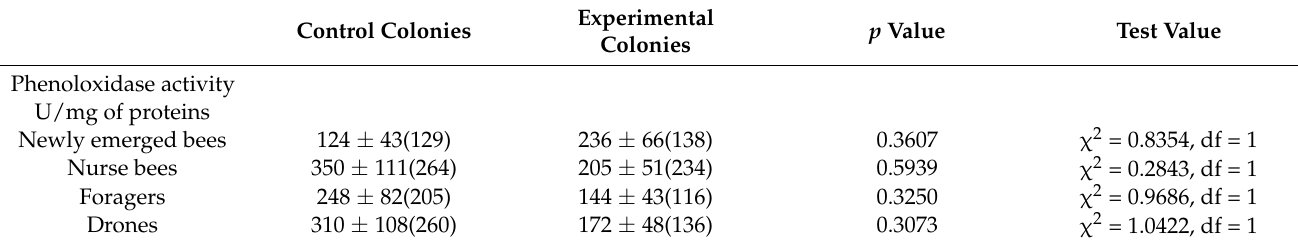
Table 1. Phenoloxidase activity in honey bees belonging to control and experimental colonies (queen caging + acid oxalic). Values are reported as mean ± SE